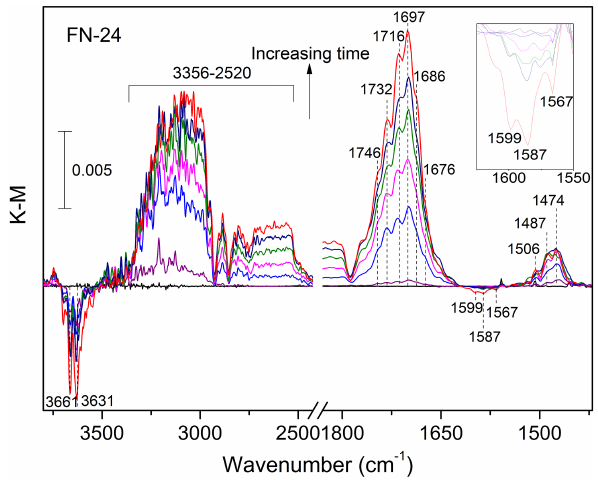
Figure 3. DRIFT spectra of FN-24 as a function of time after ex- posure to SO 2 in the range of 3800 to 1350cm − 1 . The inset shows expanded region from 1630 to 1550cm − 1